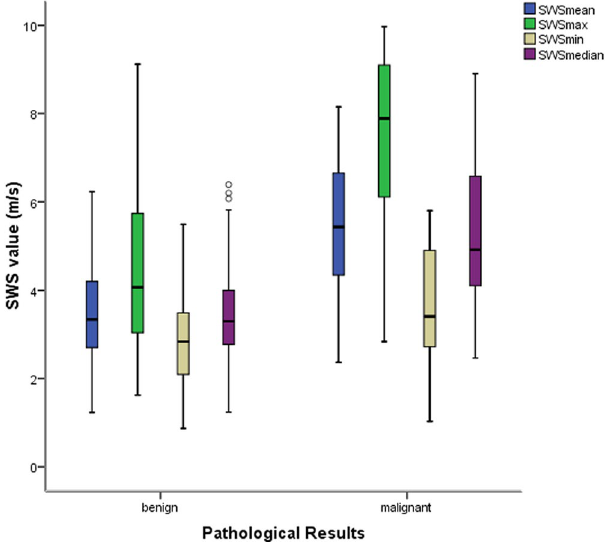
Figure 3. SWS measurements (m/s) are significantly different between benign and malignant lesions (all p < 0.05). In benign lesions, SWS max (4.46 ± 1.69, 1.62–9.12), SWS mean (3.54 ± 1.15, 1.23–6.23), SWS median (3.46 ± 1.15, 1.24–6.39) and SWS min (2.83 ± 1.02, 0.87–5.49) are lower. In malignant lesions, SWS max (7.24 ± 2.23, 2.84–9.97), SWS mean (5.34 ± 1.54, 2.37–8.15), SWS median (5.20 ± 1.68, 2.47–8.91) and SWS min (3.62 ± 1.27, 1.03–5.80) are higher.